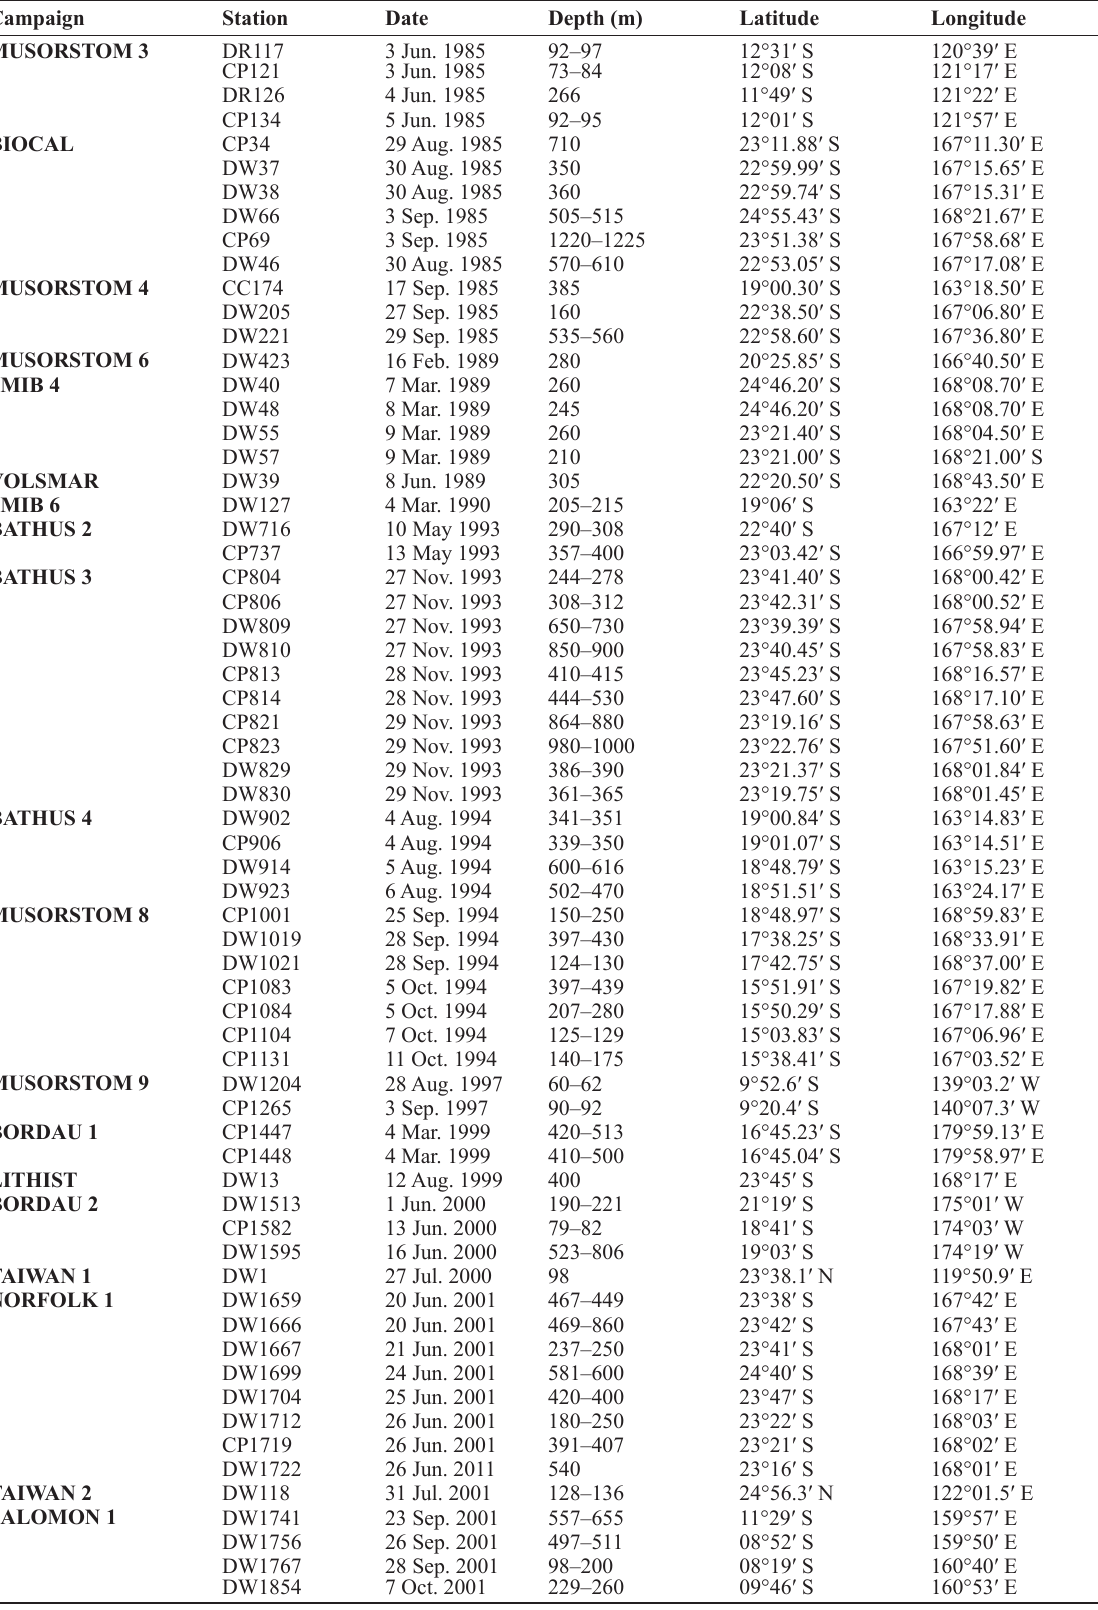
Table 1. List of